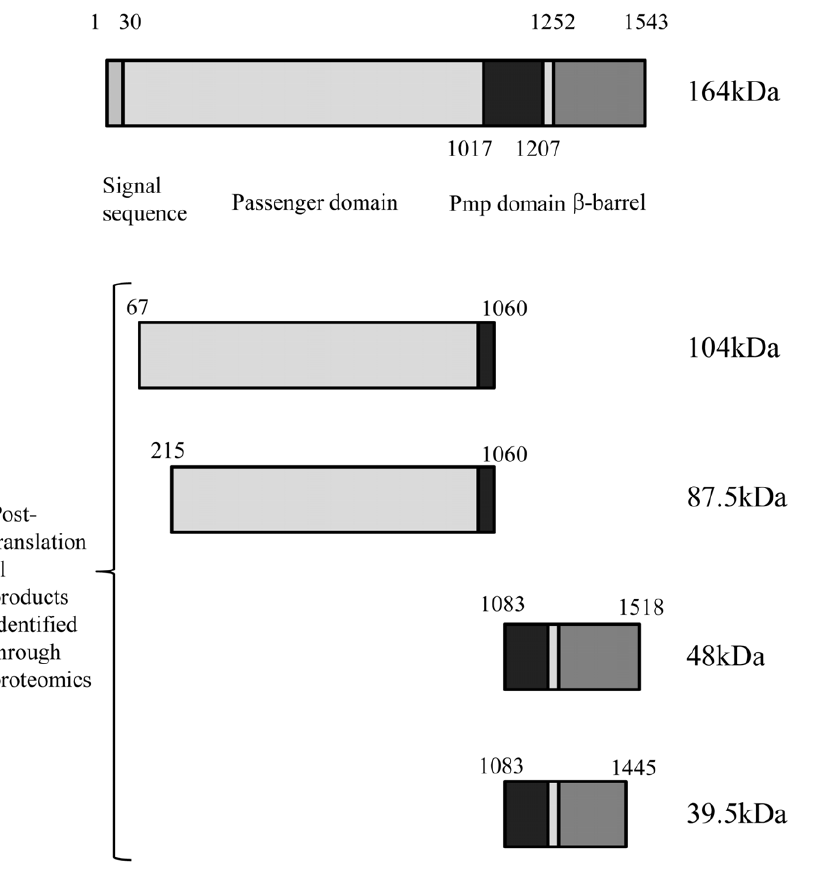
Figure 3. Schematic representation of Pmp18D cleavage products as revealed following proteomic analysis of protein fragments.